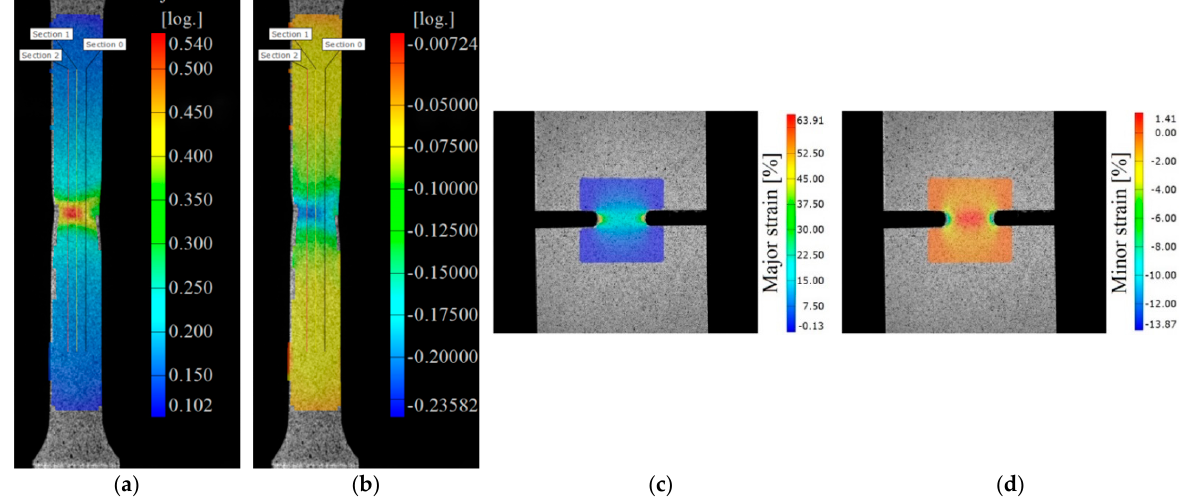
Figure 10. DIC measurements during the in-plane tests: ( a ) major strain and ( b ) minor strain fields obtained from the uniaxial tension specimen, and the selected ( c ) major strain and ( d ) minor strain fields from the double-notched plane strain specimen. Table 4. Limit strains of the CR980XG3 TM steel sheet determined from the in-plane